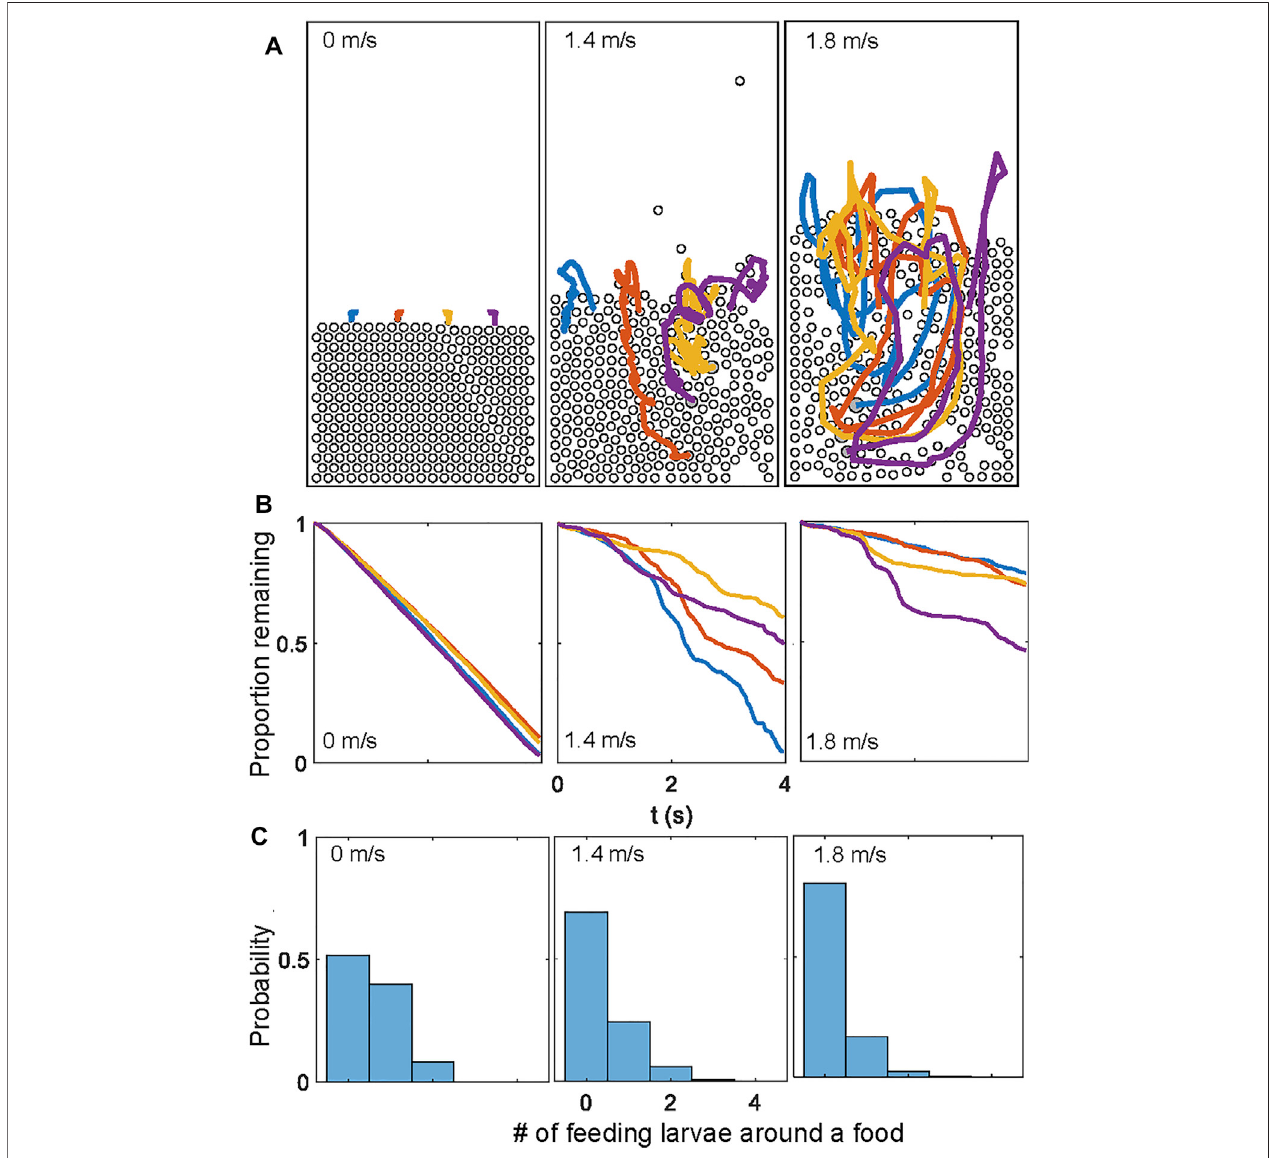
FIGURE7| Larvafeedingsimulationsfordifferentconstant fl uidizationairspeeds. (A) Trajectoriesofthefourfoodparticles. (B) Timeseriesoftheproportionoffood remaininginthesimulation overapproximately4 seconds. Thefeedingratesaresigni fi cantlyspedupinthesimulations. (C) Thehistogramofnumbersof “ eating ” larvae, de fi ned as those contacting and consuming food in each time step.